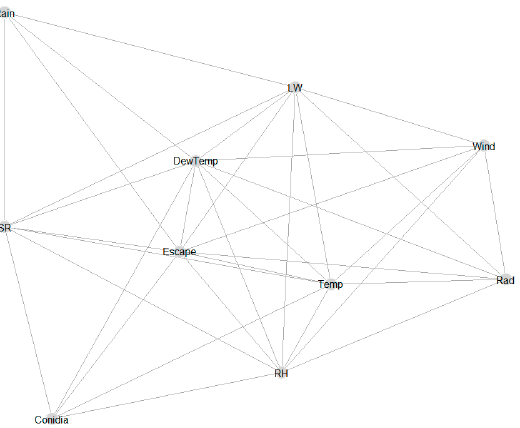
Figure 3. A graphical model showing the conditional dependence of different hourly weather vari- ables and hourly concentrations of A. solani and A. alternata represented by the conidia variable. Variables that are connected by a line are conditionally dependent or correlated significantly and vice versa. The weather variables were relative humidity (RH), temperature (Temp), wind speed (Wind), dew temperature (DewTemp), leaf wetness (LW), solar radiation (Rad), and rainfall (Rain). The probability that conidia will be released is identified by the variable spore release (SR) and the probability that conidia will escape from the canopy is named escape (Escape).